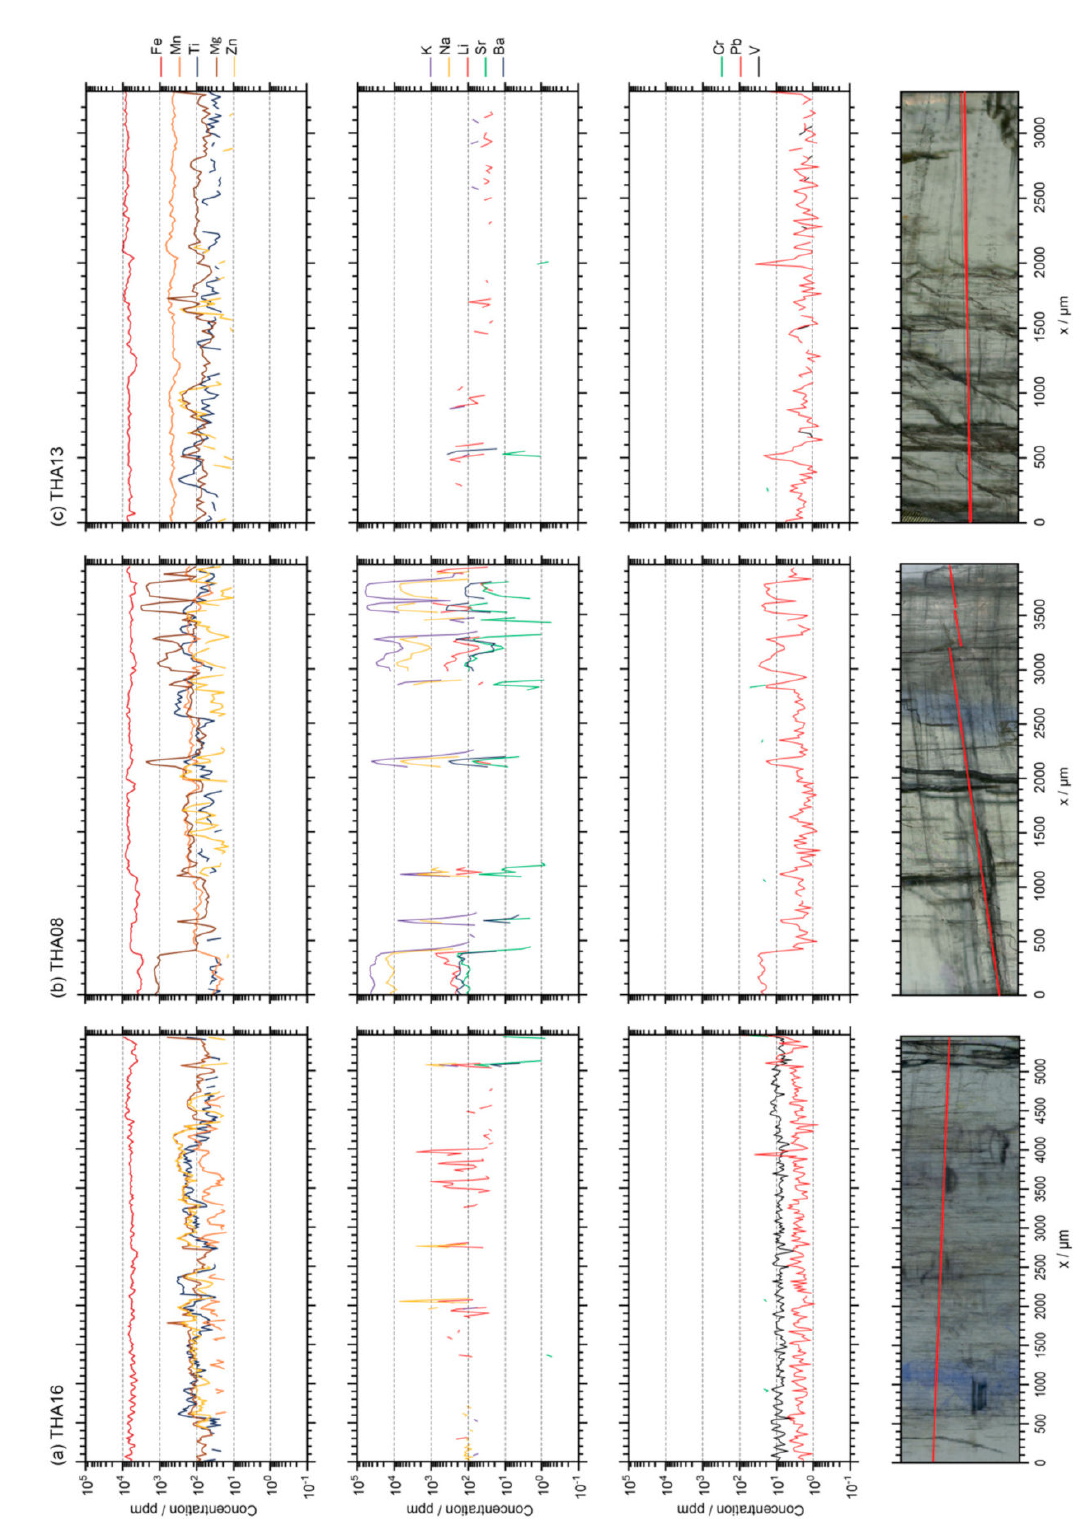
Figure 13. Quantitative Laser Ablation-Inductively Coupled Plasma Mass Spectroscopy (LA-ICPMS) analyses (in ppm) on the < 100 > faces of blue-green THA16 ( a ), yellow THA08 ( b ) and orange THA13 ( c ) kyanite samples from border to border of the crystals. The location of the profiles (red line) is approximately at the same position as that of EPMA analyses. The element concentration lines might be discontinuous due to values below detection